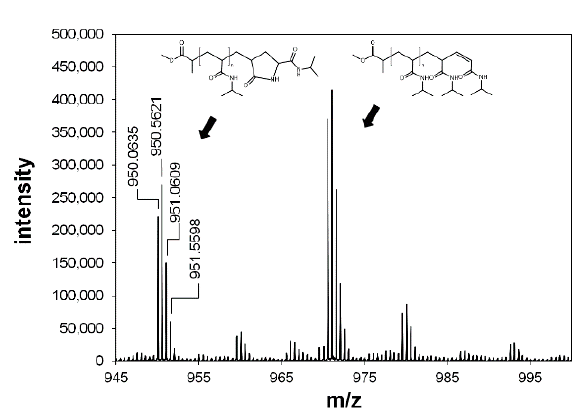
Figure 2. ( a ) Drift time spectrum of the PNIPAAm homopolymer sample C1. The marked region was used for data extraction to obtain a simplified ESI-TOF mass spectra; ( b ) extracted ESI-TOF spectrum; ( c ) magnified region with single series.